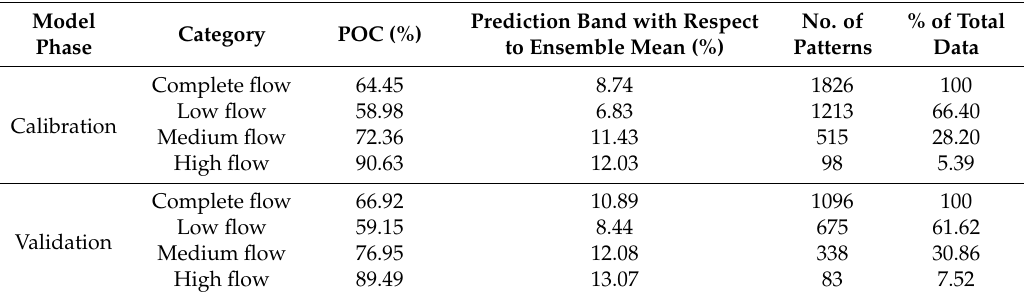
Table 4. Estimates of uncertainty indices in different flow domains for the VIC and ANN model (daily). POC, percentage of coverage.